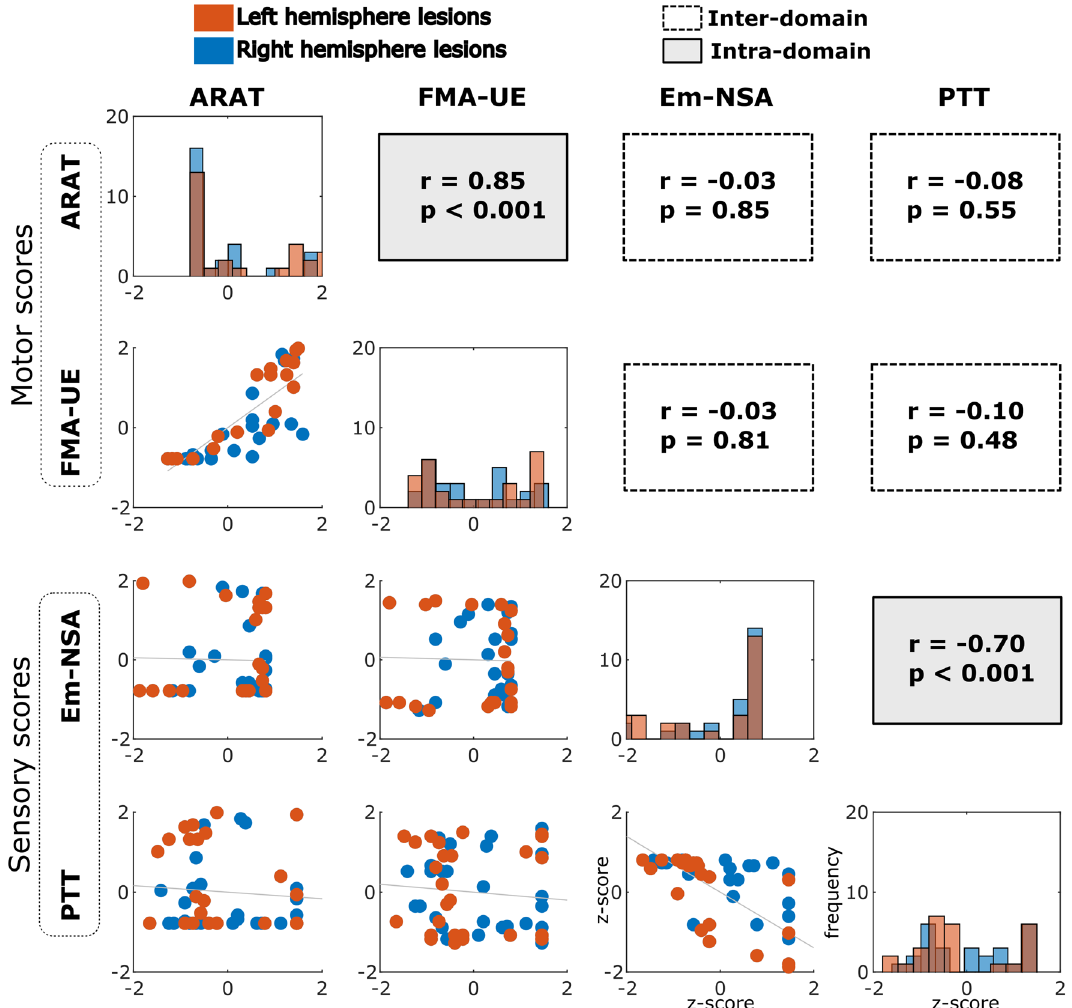
Figure 2. Distribution of behavioral—motor and sensory—scores. The principal diagonal panels represent the histogram values for each of the four behavioral scores, two being motor scores (ARAT and FMA-UE) and two somatosensory scores (Em-NSA and PTT). Off-diagonal panels (below the diagonal) show scatter plots between pairs of scores. We also provided Pearson correlation values (r) and associated p-values above the diagonal in the off-diagonal panels. The red and blue colors represent scores from patients having lesions in the left and right hemispheres, respectively. Behavioral outcome differences between patients with left and right hemisphere lesions were not significant (ARAT χ 2 = 0.85, p = 0.36; FMA-UE χ 2 = 0.003, p = 0.96; Em-NSA χ 2 = 0.69, p = 0.41; PTT χ 2 = 0.44, p = 0.51). Because these reasons, the left and right lesion datasets were pooled into a single cohort in this study. All the scores are represented here as